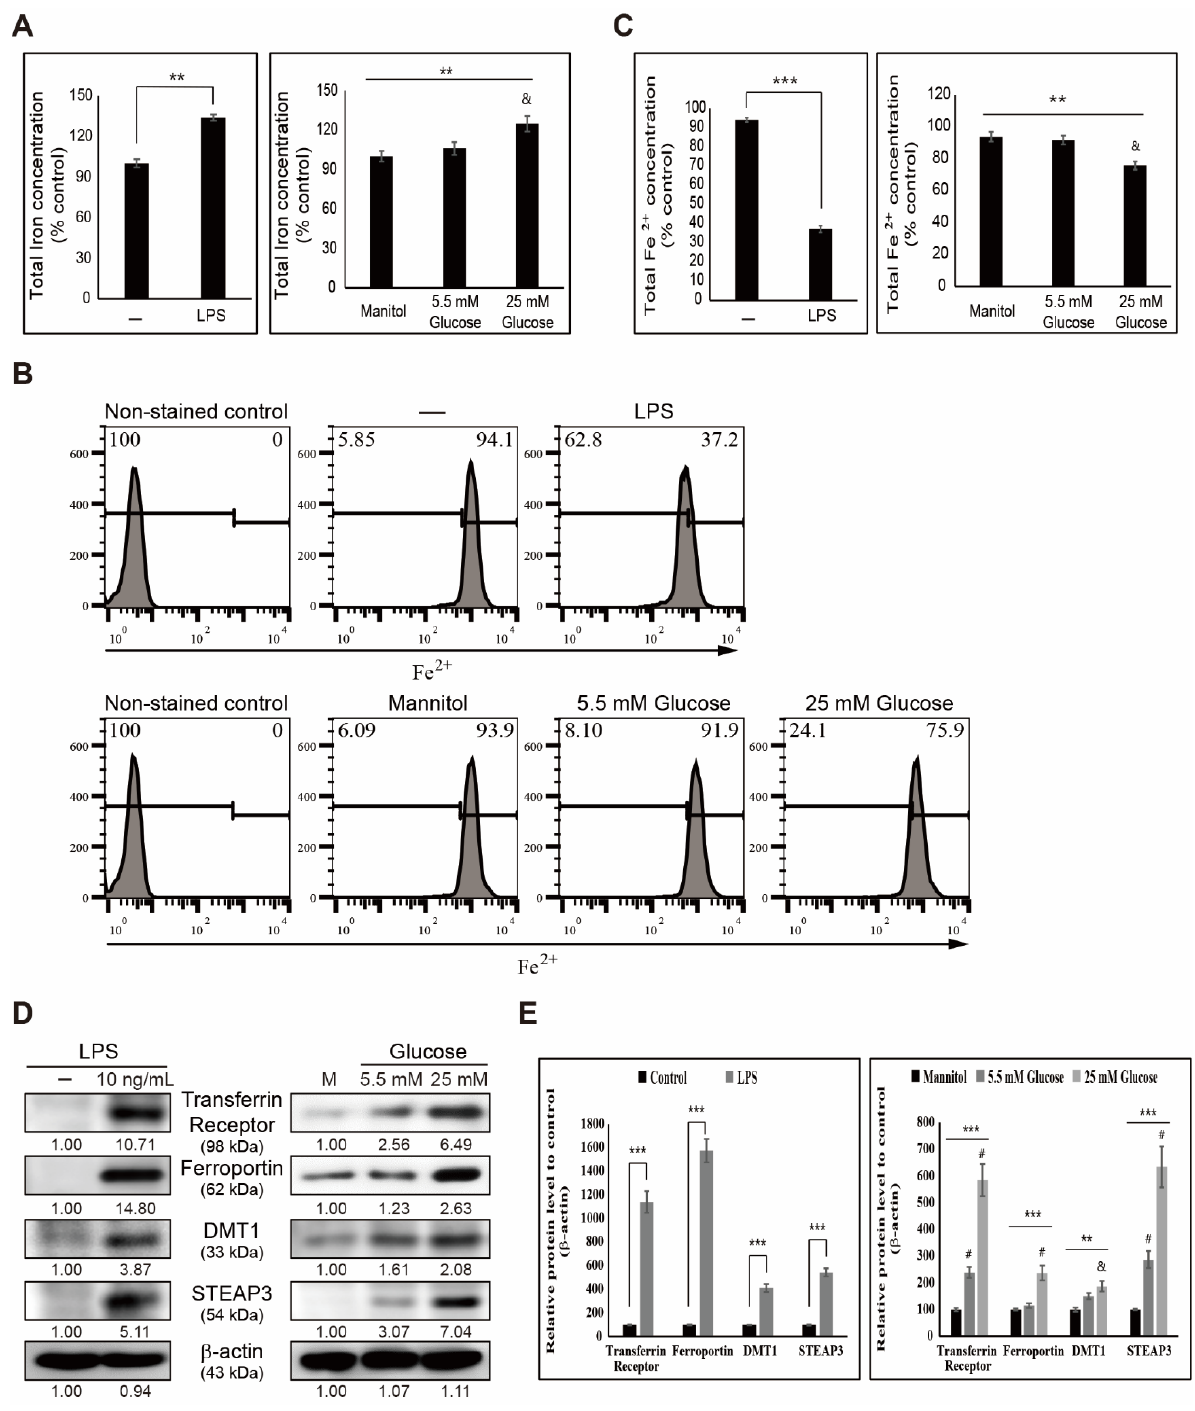
Figure 1. Induced inflammation increases iron metabolism. ( A ) Iron assay showing total iron concentration in THP-1 cells treated with LPS (10 ng/mL) for 48 h and mannitol or glucose (5.5 and 25 mM) for 72 h. Data obtained after three experiments. ** p < 0.01, control vs. LPS ( t -test). ** p < 0.01, mannitol vs. high glucose (ANOVA test). The mean difference is significant at the 0.01 level. & p < 0.01 vs. control. ( B ) Flow cytometry showing the expression of Fe 2+ in THP-1 cells after treatment with LPS (10 ng/mL) for 48 h and mannitol or glucose (5.5 and 25 mM) for 72 h. Data are representative of three independent experiments. ( C ) Graphical representation of flow cytometry showing the expression of Fe 2+ in THP-1 cells after treatment with LPS (10 ng/mL) for 48 h. Data are representative of three independent experiments. *** p < 0.001 ( t -test). Graphical representation of flow cytometry showing the expression of Fe 2+ in THP-1 cells after treatment with mannitol or glucose (5.5 and 25 mM) for 72 h. Data are representative of three independent experiments. ** p < 0.01 (ANOVA